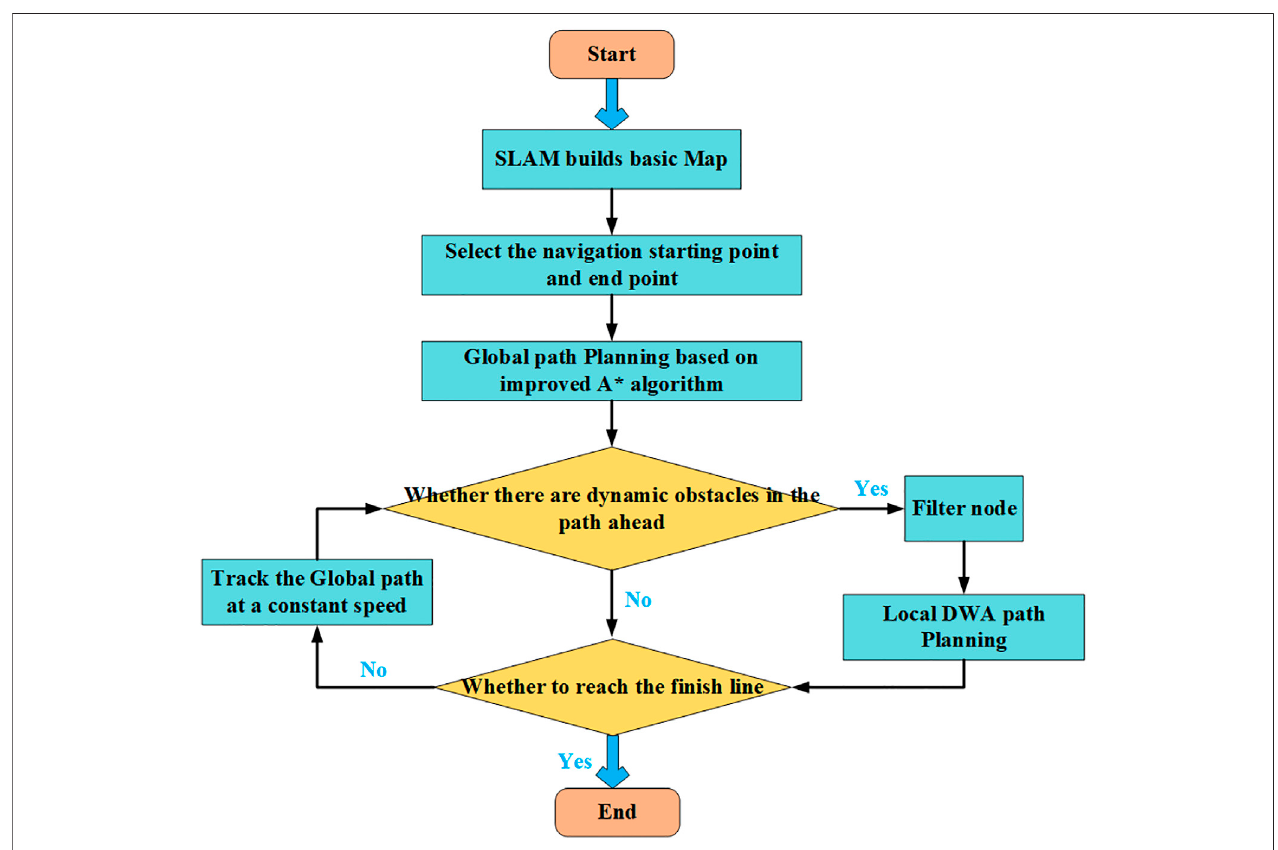
FIGURE 2 | Multiple trajectory generation graphs of the